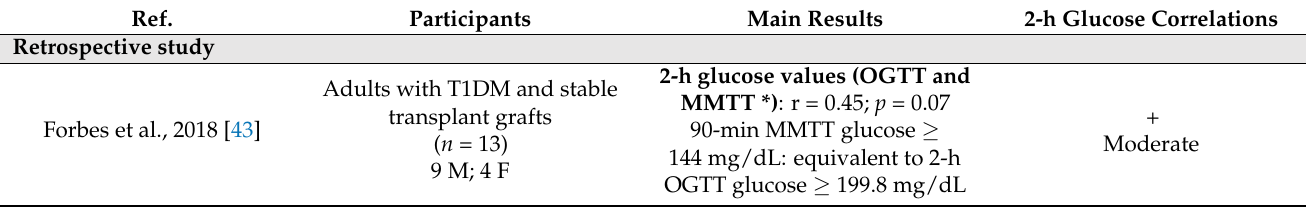
* Nutritional composition described in Table 2. DM, Diabetes Mellitus; M, Male; F, Female; OGTT, Oral Glucose Tol- erance Test; IGT, Impaired Glucose Tolerance; NGT, Normal Glucose Tolerance; NIDDM, Non-Insulin-Dependent